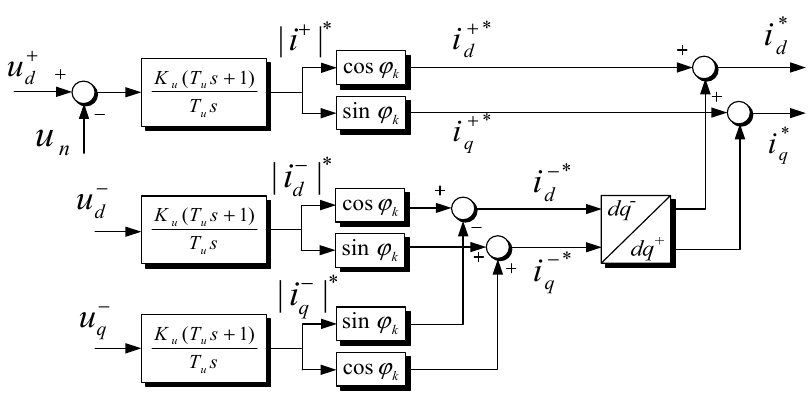
Figure 5. Voltage controller operating in DSRF (* denotes reference values).